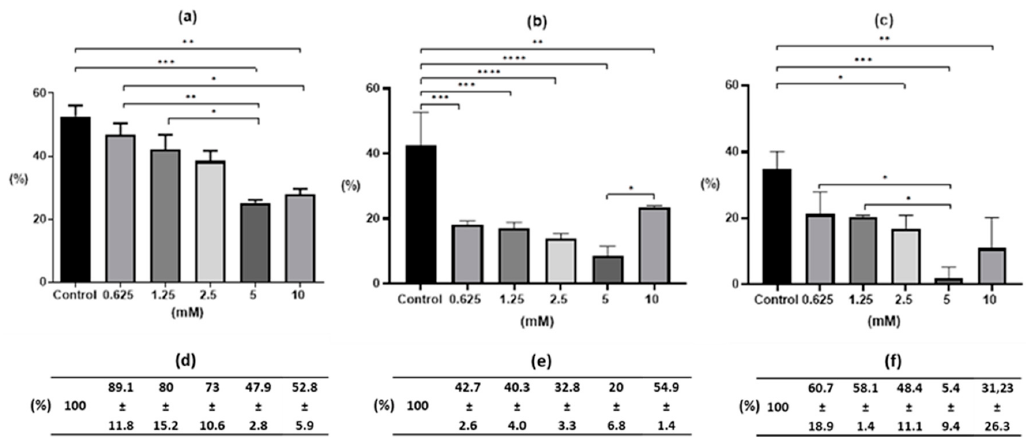
Figure 1. Percentage of L 2 larvae from Ascaris suum egg in vitro incubation according to time exposure and S -M-(-2MKA-BZ-5)TS concentration: ( a ) 24h-; ( b ) 48h-; ( c ) 72h-drug exposure. Notes: * significant difference at p < 0.05; ** significant difference at p < 0.01; *** significant difference at p < 0.001; ****